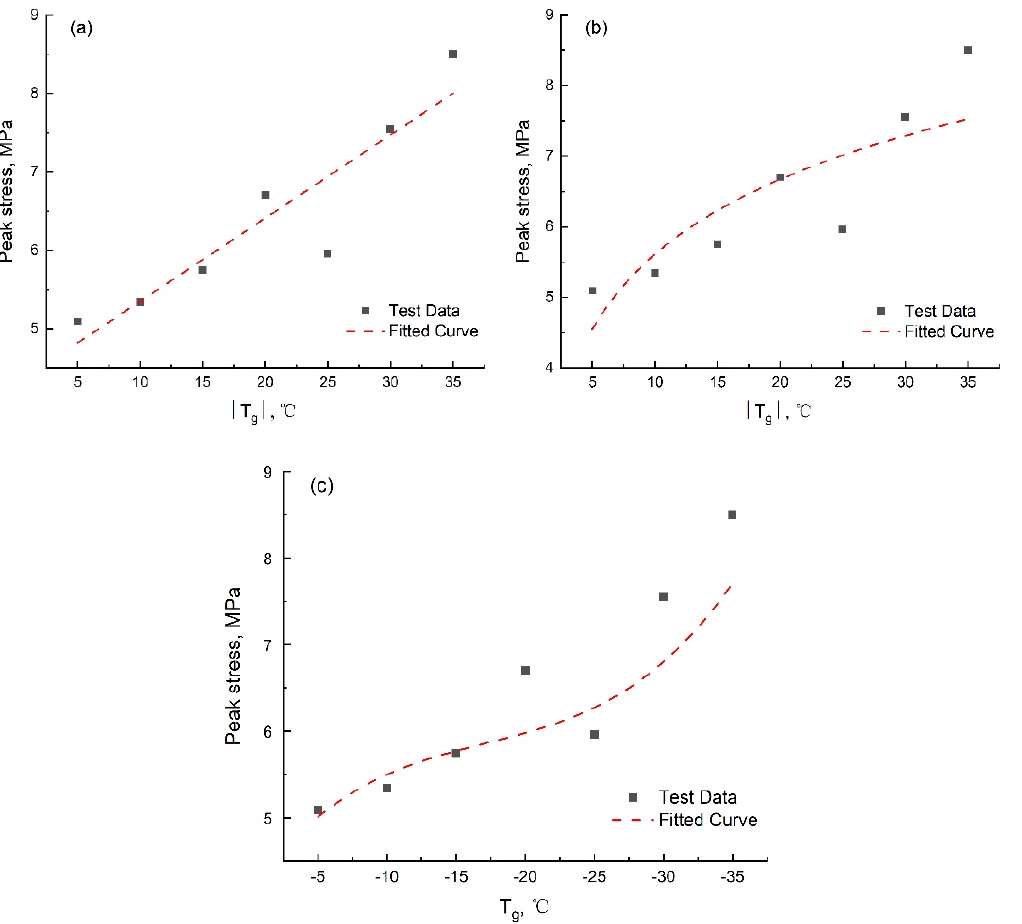
Figure 13. Peak stress versus growth temperature and curves fitted with different function types. Solid squares are test data. Dashed lines are fitted curves. ( a – c ) are linear, logarithmic and polynomial function respectively.